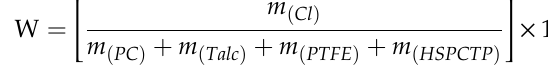
Table 2. Flame retardancy of the PC/HSPCTP blends.